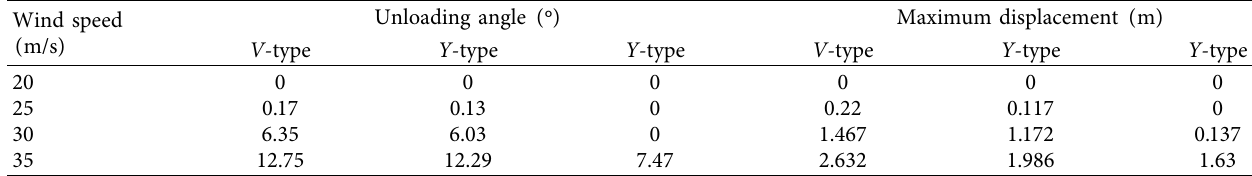
Figure 12: (a) Te deformation of the V -type insulator string with wind speed 45m/s. (b) Te deformation of the Y -type insulator string with wind speed Table 6: Te comparison of analysis results between the no. 1 and no. 2 insulator strings.